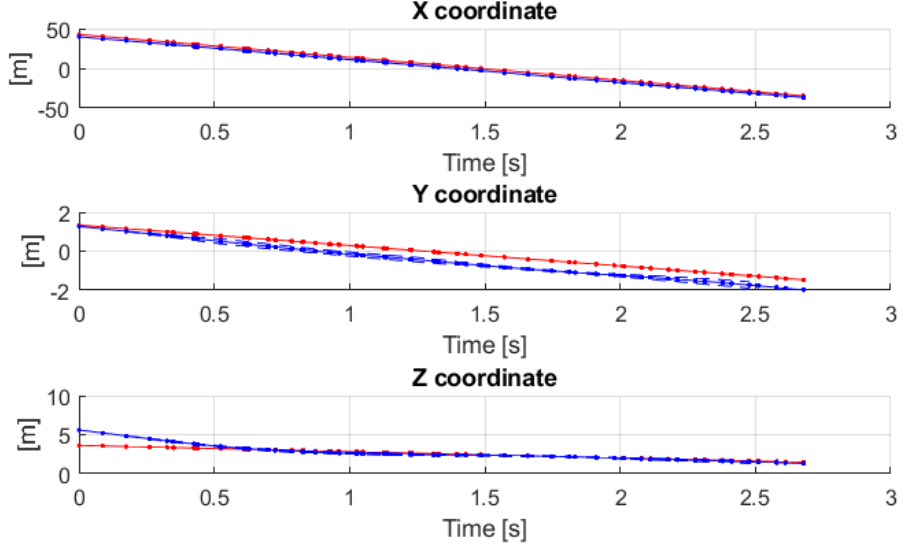
Figure 16. Estimated coordinates of a landing Cessna airplane using VM ‐ CV (red) and CT (blue)